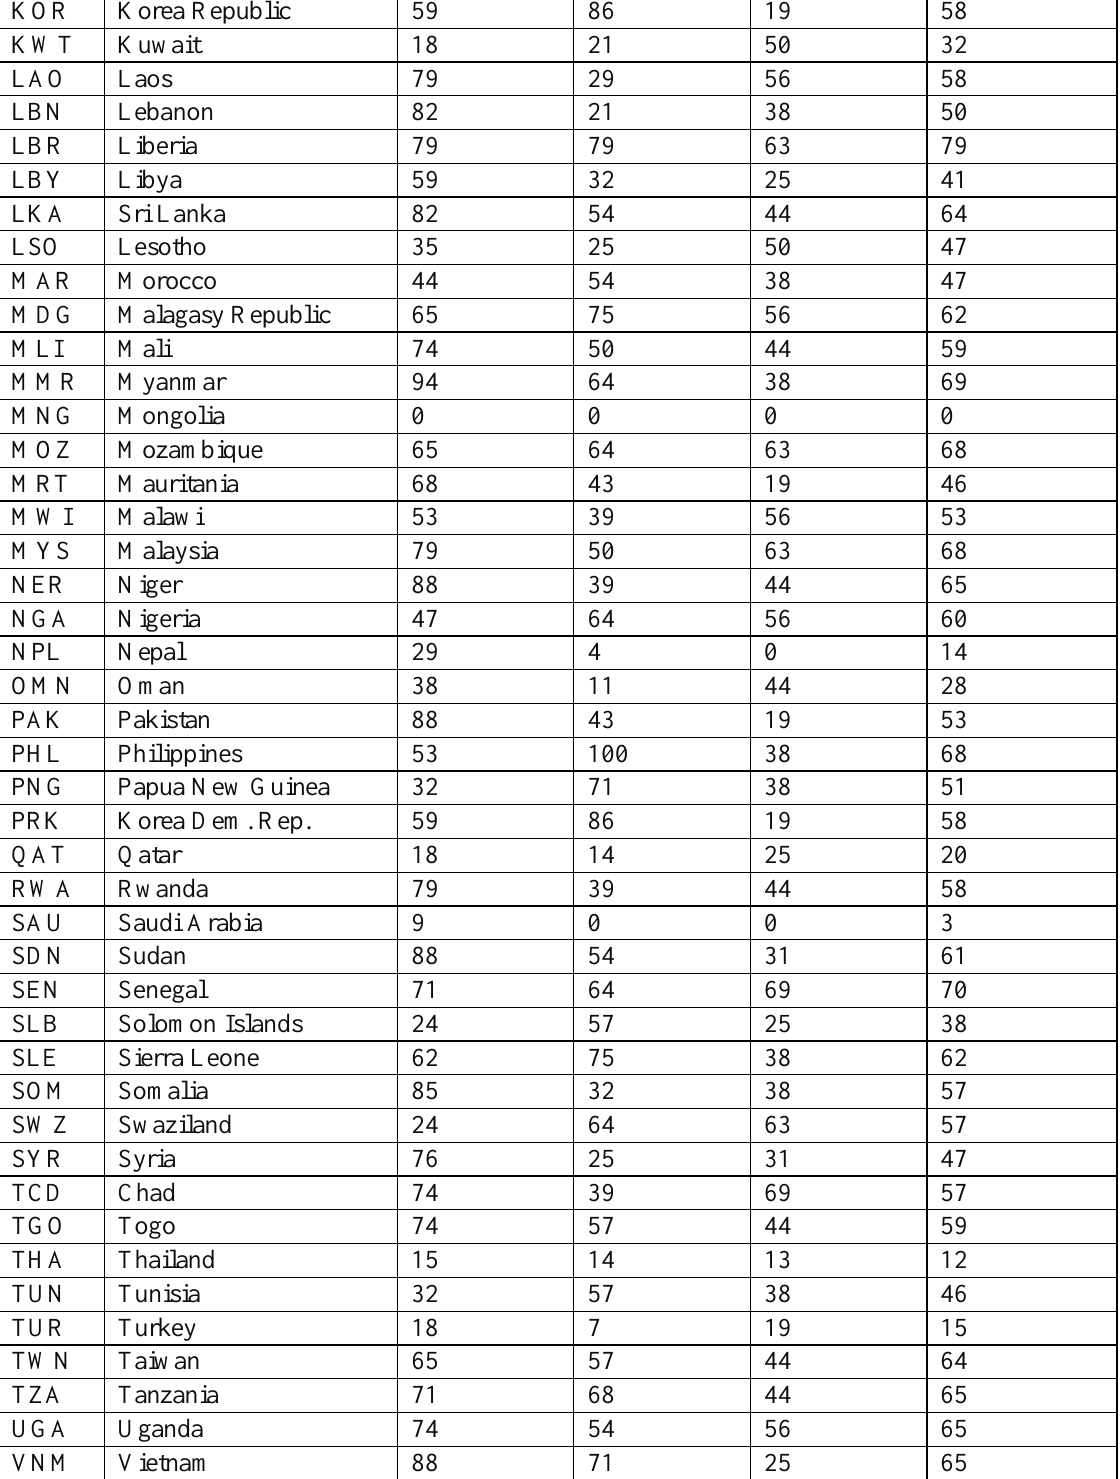
Table 2. Indices of Colonial Transformation (Continued)